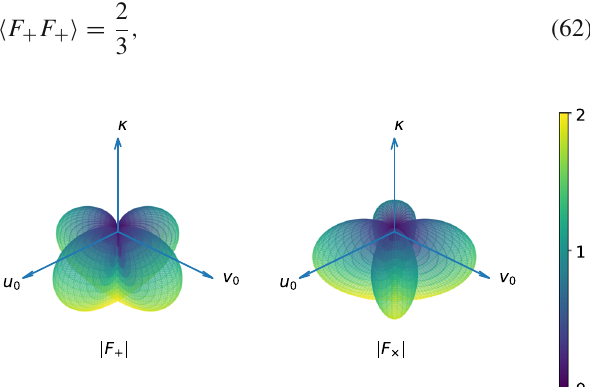
Fig. 1 Antenna patterns of | F + | and | F × | for the measurement of h ; as viewed in consideration with gravitational waves propagating along the direction of the κ -axis while being polarized in the u v -plane in a quadrupole manner. The frame { u 0 , v 0 , κ } is defined from an adapted frame { u , v , κ } with ψ = 0. In this frame, the polar angle is defined as ϑ = π − θ , where θ refers to the angle between the propagation direc- tionsofgravitationalandelectromagneticwaves,whereastheazimuthal angle is defined as ϕ = π/ 2 +